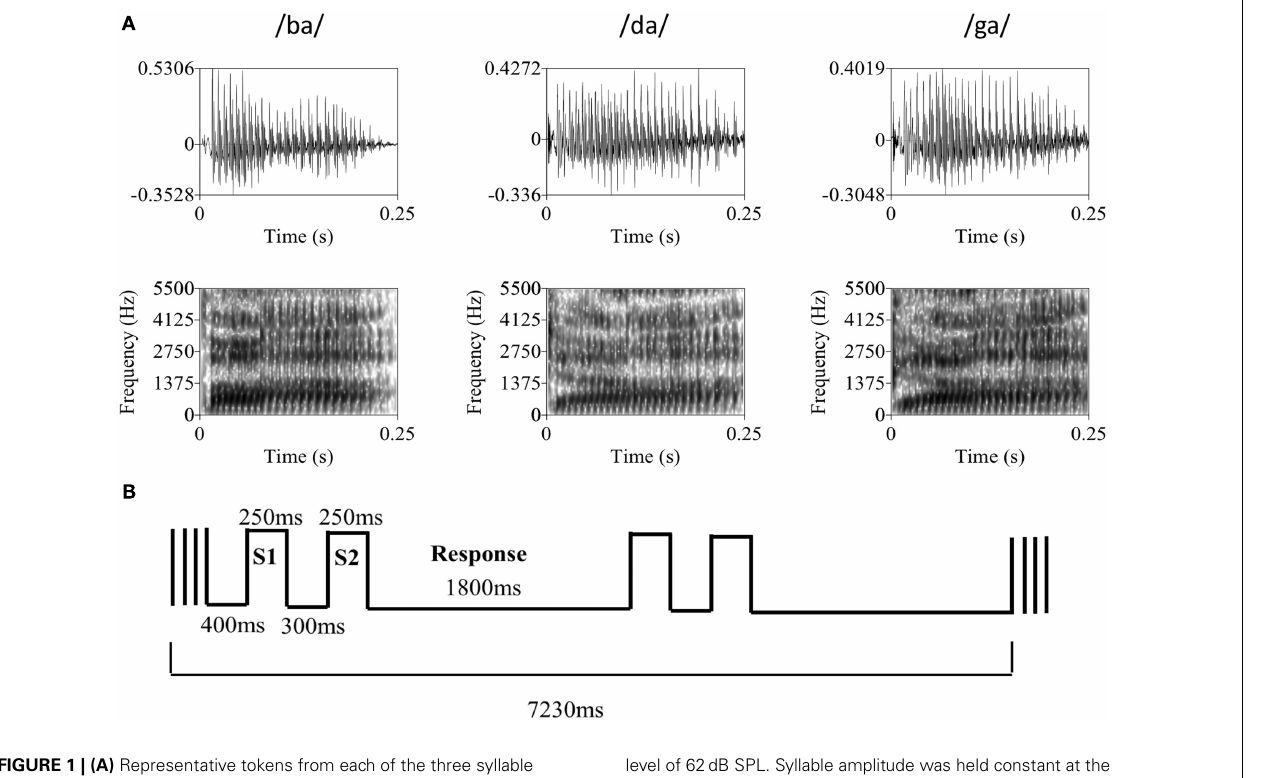
level of 62dB SPL. Syllable amplitude was held constant at the psychophysically determined threshold level (mean SNR =− 13.1dB). (B) The basic trial and block structure of the fMRI experiment. Each block consisted of two same-different discrimination trials with 250ms auditory syllable presentations separated by a 300-ms ISI. Subjects had 1800ms to respond. Trials occurred in the silent period between 1630ms volume acquisitions, with a 400ms silent period at the beginning of each block of two